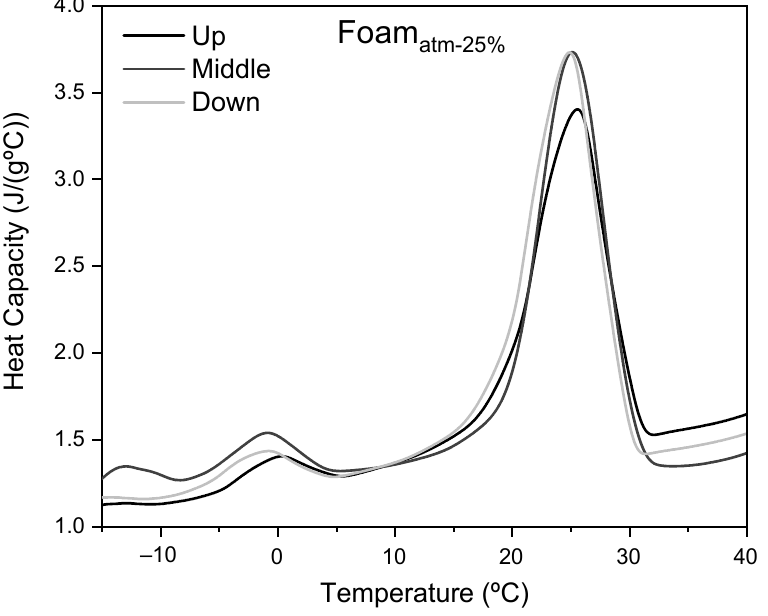
Figure 10. Heat Capacity of Foam 800-25% as function of the temperature at different heights. As can be seen, the thermograms obtained at different heights are similar to each other. Focusing on the main peak, the onset temperatures of the composite are in the range of 18.5 °C to 19.5 °C, with a temperature of maximum heat capacity from 24.4 °C to 25.7 °C. The latent heat of the samples can be obtained from the integration of the heat capacity profile. Based on the observations in all samples, no trend in the latent heat distribution along the foam has been found. Table 2 shows the average latent heat depending on the operating pressures and their standard deviations. Table 2. Latent heat from DSC analysis and standard deviations of the measurements.